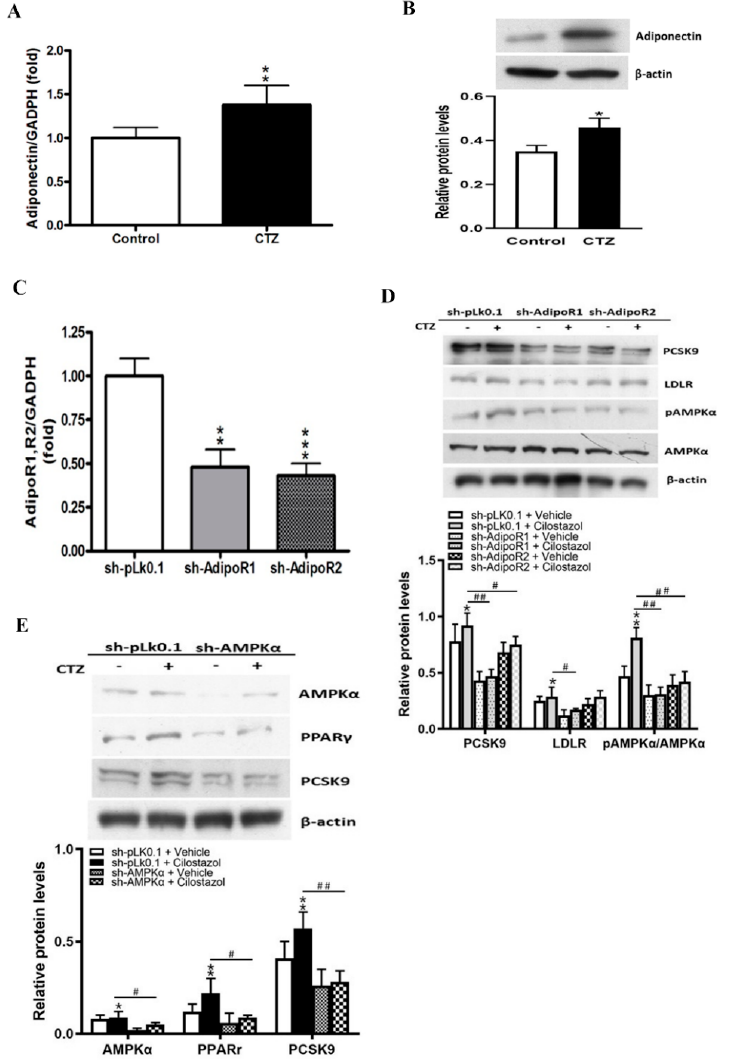
control is shown below. ( C ) Representative images of immunofluorescence staining with LDLR (red), 4 ′ ,6-diamidino-2-phenylindole (DAPI) (nucleus, blue), and their colocalization (merge). Scale bar = 20 μ M. ( D ) Quantification of LDLR mRNA expression in the cilostazol-treated groups. The total cellular RNA was used to determine LDLR mRNA expression by Cell-RNA-cDNA real-time PCR. The results are represented as the mean ± S.E.M. from three independent experiments. ( E ) LDLR promoter was conducted with the mutation of SRE (pLDLR-SREmut). Expression vector of human LDLR promoters were constructed by PCR with the genomic DNA isolated from HepG2 cells. Cells were transfected with DNA for LDLR promoter and expression vector of wild type or SRE mutation (pLDLR-SREmut) followed by treatment with cilostazol at the indicated concentrations overnight. ( F ) HepG2 cells were treated with cilostazol (30 μ M) overnight. Chromatin was isolated followed by immunoprecipitation with normal IgG or anti-SREBP-2 antibody. The PCR was conducted with primers for SRE in the PCSK9 promoter. ( G ) Protein levels of precursor (P) and mature (M) forms of SREBP-2 in HepG2 were measured by Western blotting. β -actin was used as a loading control.